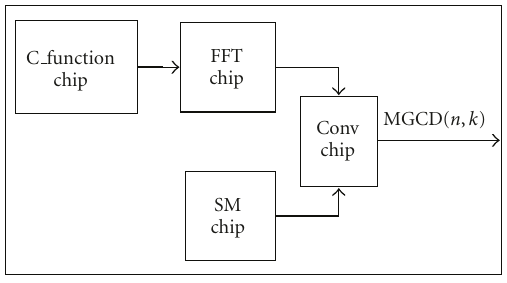
Figure 14: A block scheme for the FPGA implementation. Table 6: Characteristics for the chip in Figure 16.